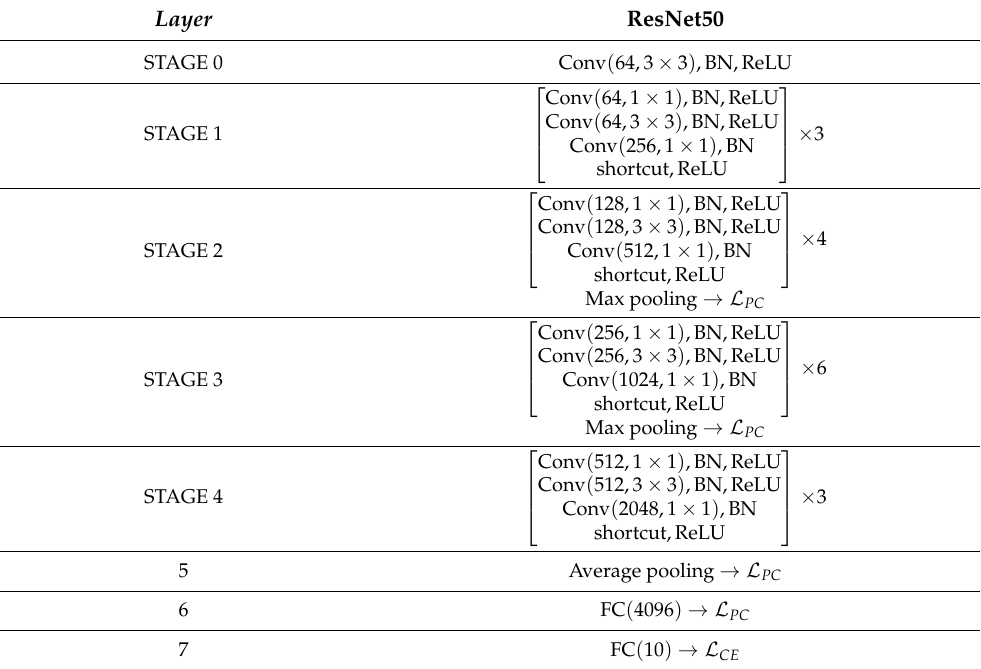
Figure 1. Architecture details of the proposed EMSF 2 Net. We use ResNet50 [30] as the backbone of the proposed EMSF 2 Net. The structures of STAGES 0–4 to are the same as those in baseline, where their details are presented in Table 1. In this figure, the FE Block represents the feature enhancement block; the Concat represents the concatenation operation; and the GAP in the FE Block represents the global average pooling. Table 1. Architecture details of the baseline in our method. Among them, L PC represents the loss of the regularization method proposed by Mustafa et al. [26], and L CE represents the common cross-entropy